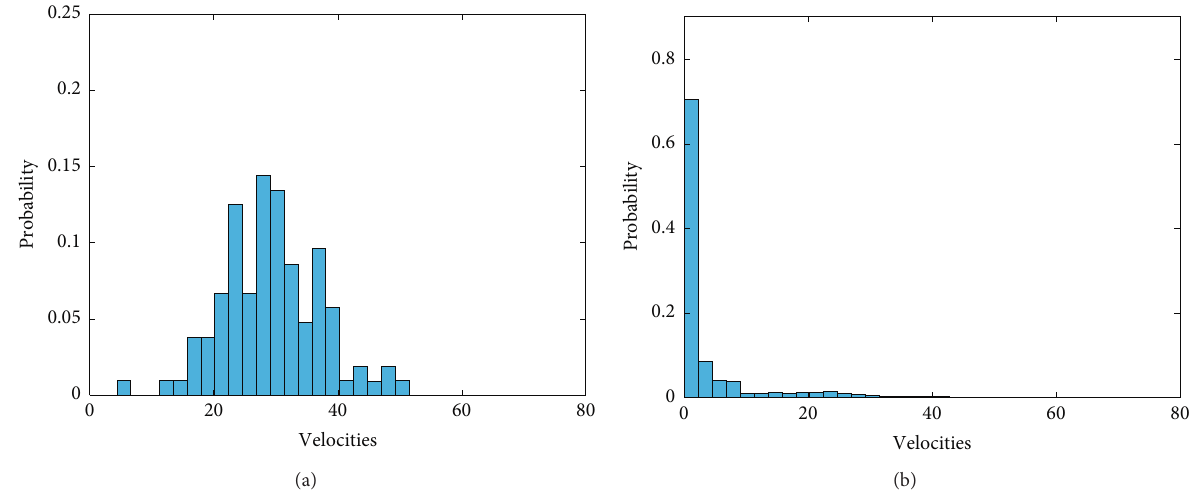
Figure 2: The probability distribution of velocities of the NTU-SBS from 23 August 2018 to 11 November 2018. (a) Empirical distribution of velocities of the buses at position x � 252, which is the middle of a straight stretch of road. (b) Empirical distribution of velocities of the buses at position x � 61, which is upstream of a